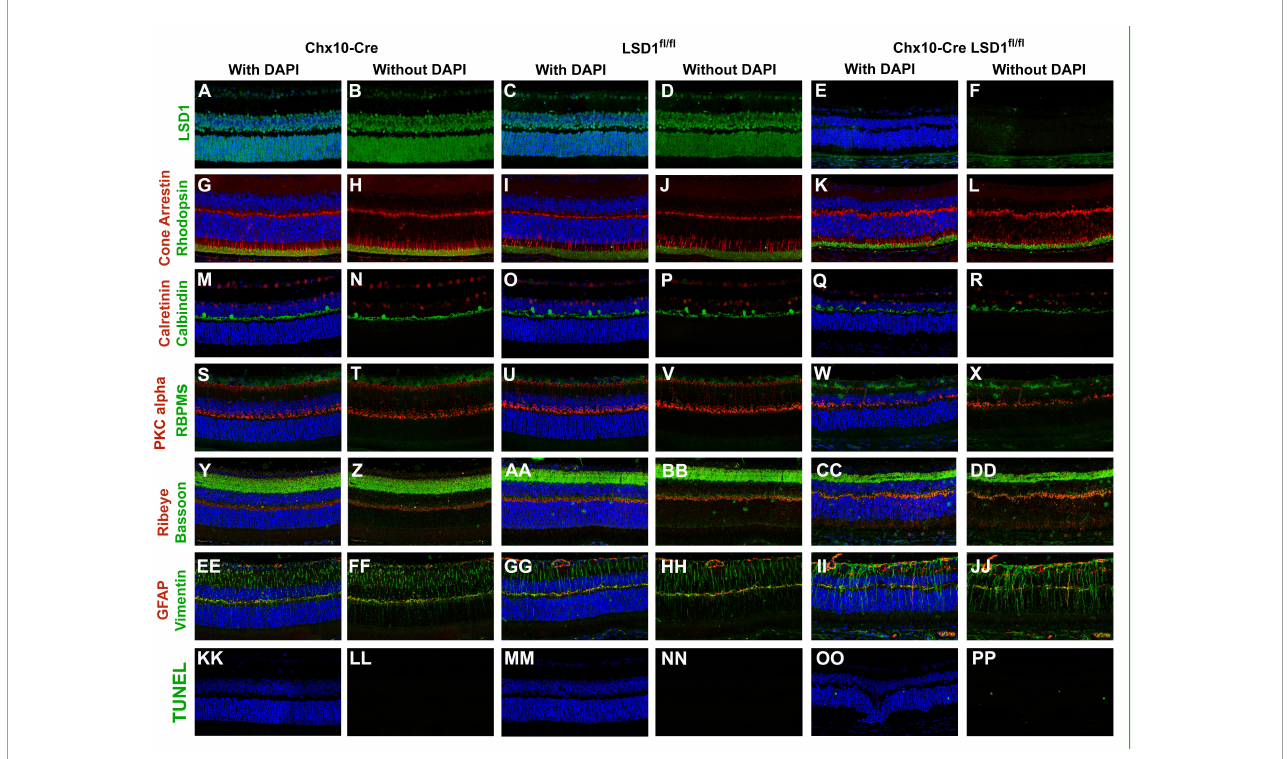
FIGURE6 Immunofluorescence staining of Lsd1, various major cell specific markers, and TUNEL show decreased presence of specific retinal neurons and increased apoptosis in Chx10-Cre Lsd1 fl / fl animals compared to controls. Lsd1 protein has little to no expression in Chx10-Cre Lsd1 fl / fl animals [panels (E,F) ] compared to both control groups [panels (A–D) ]. Qualitatively, expression of photoreceptor marker cone arrestin and rhodopsin [panels (G–L) ] are relatively consistent across the three groups. Expression of calretinin was qualitatively uniform across the three groups; however, calbindin positive cell bodies seem reduced in the Chx10-Cre Lsd1 fl / fl animals [panels (Q,R) ] compared to controls [panels (M–P) ]. RBPMS expression was qualitatively uniform across the three groups, but PKCalpha was reduced in the Chx10-Cre Lsd1 fl / fl animals [panels (W,X) ] compared to controls [panels (S–V) ]. Bassoon and Ribeye staining [panels (CC,DD) ] seems qualitatively different in the Chx10-Cre Lsd1 fl / fl compared to controls [panels (Y–BB) ]. Expression of Muller glia cell markers Vimentin and GFAP had a qualitatively increased co-localization in the Chx10-Cre Lsd1 fl / fl [panels (II,JJ) ] compared to controls [panels (EE–HH) ]. No TUNEL positive cells were observed in the control groups [panels (KK–NN) ], but several were observed in the Chx10-Cre Lsd1 fl / fl animals [panels (OO,PP) ]. Samples sizes: Chx10-Cre ( n = 5), Lsd1 fl / fl ( n = 5), Chx10-Cre Lsd1 fl / fl ( n =